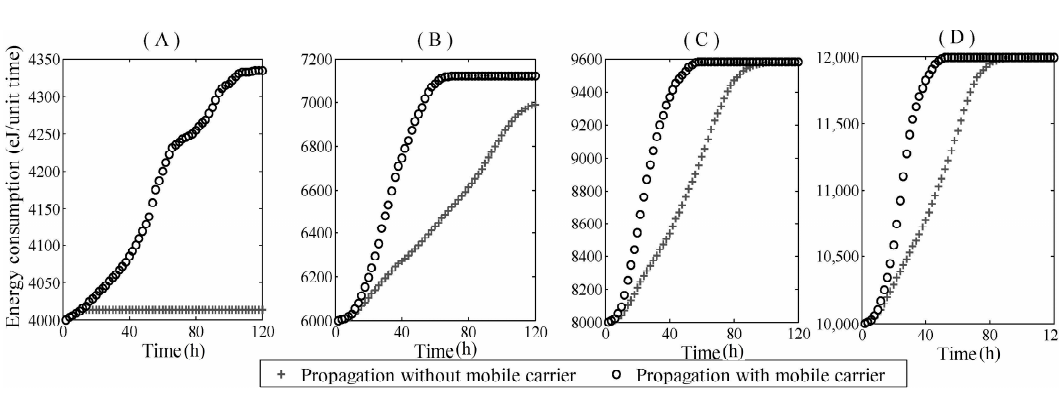
Figure 7. Our mathematical model vs. Mohammad’s individual boundaryless model (the network sizes of ( A ), ( B ) are 6000 and 10,000); I(t) means the number of infectedsensor nodes.